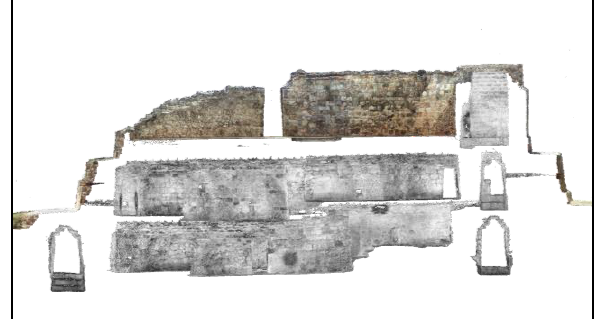
Figure 3. Longitudinal section view of Satunsat, facing west